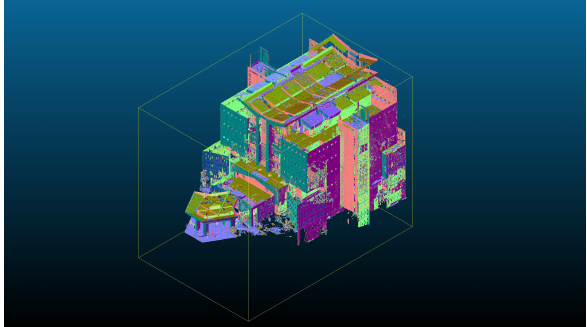
Figure 3. Normals computed for each point and converted to HSV